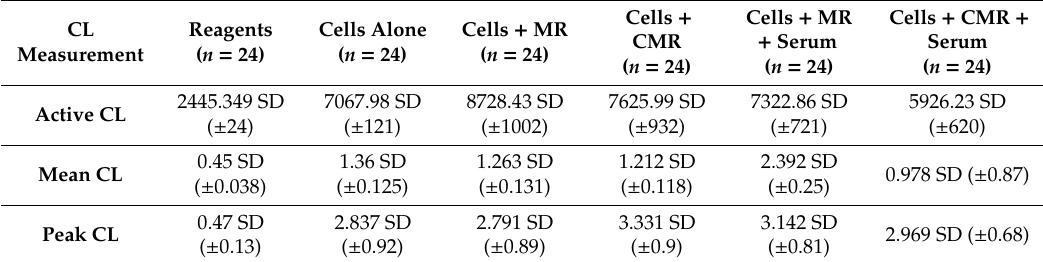
Table 1. Mean chemiluminescence (CL) values.